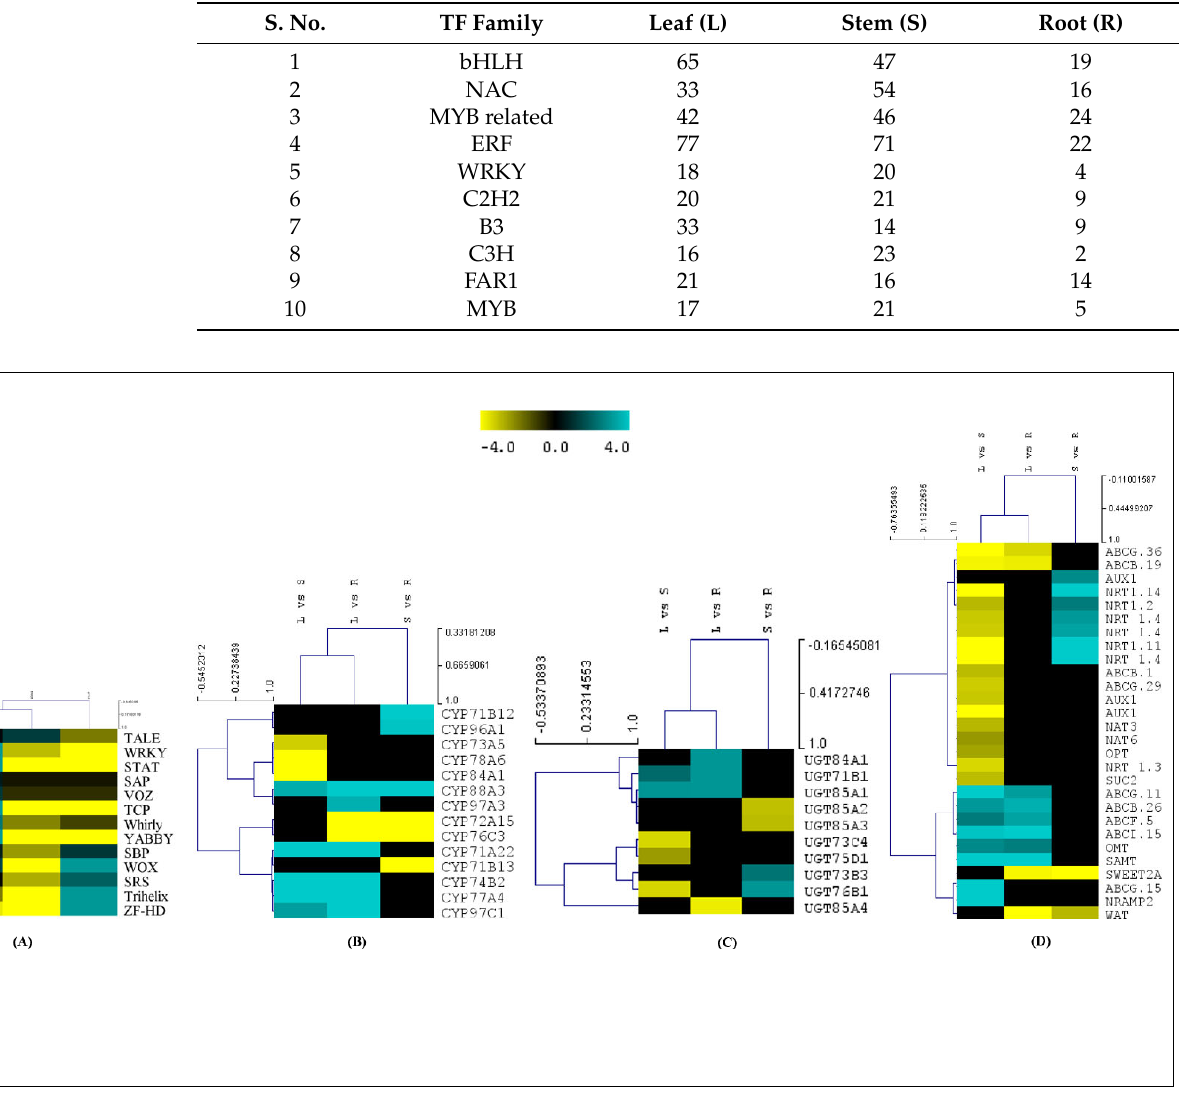
Table 4. Tissue ‐ specific expressions of abundant TFs encoding transcripts in A. glauca. Table 4. Tissue-specific expressions of abundant TFs encoding transcripts in A. glauca . S. No.